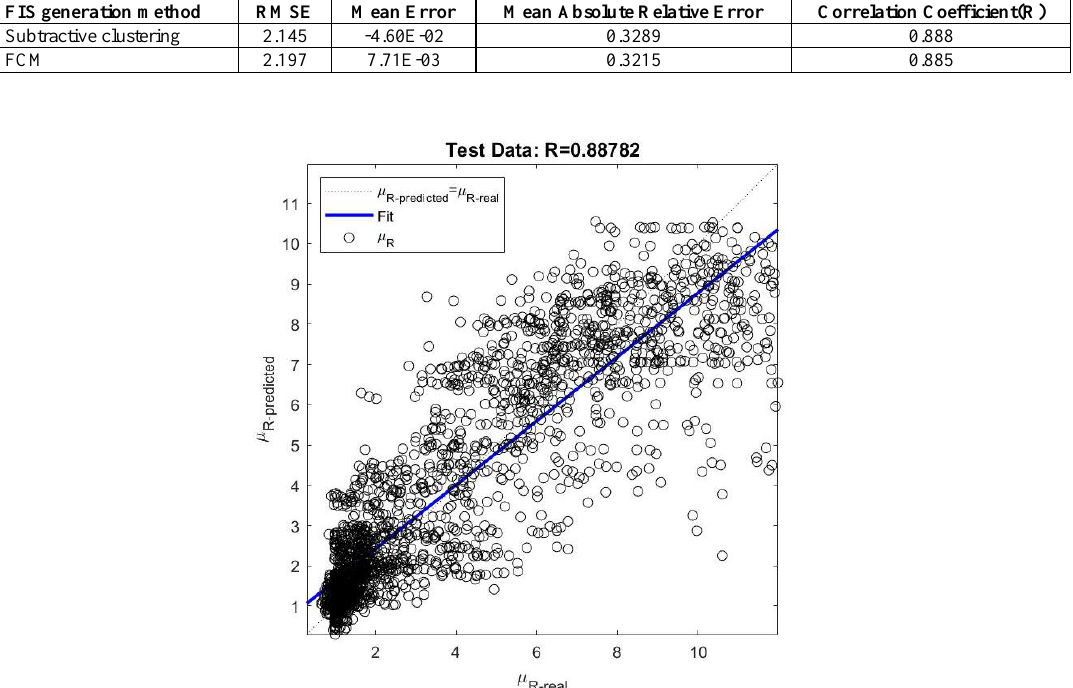
Table 8. Results of evaluating different ANFIS models for testing data